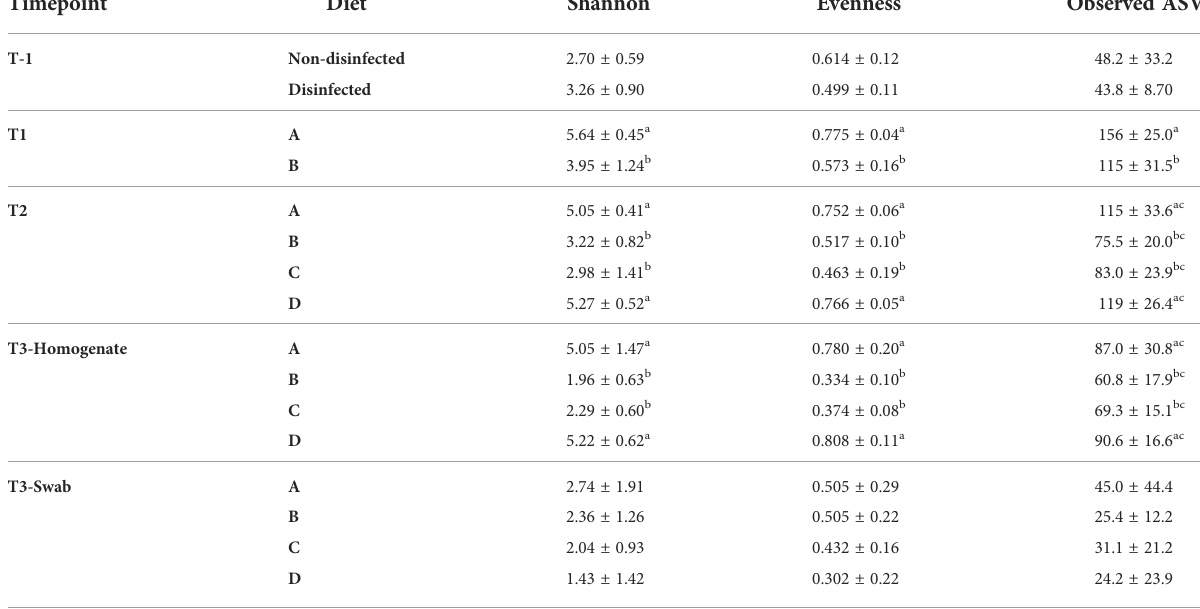
TABLE 4 Summary of alpha diverisity analyses (mean ±